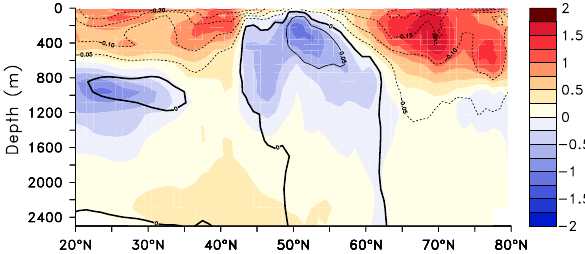
Figure 6. Simulated 20th-century linear trends (1905–2005) as zonal averages over the Atlantic Basin for potential temper- ature (colour shading) and density (contours, contour interval 0.05kgm − 3 ) trends from the pr2 experiment.